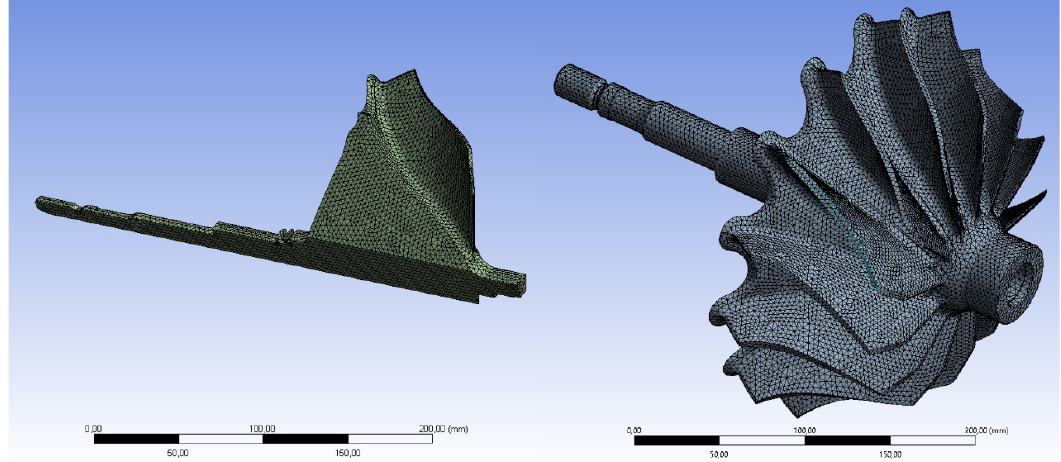
Figure 2. An illustration of one sector and whole mesh of the turbine bladed disc structure.